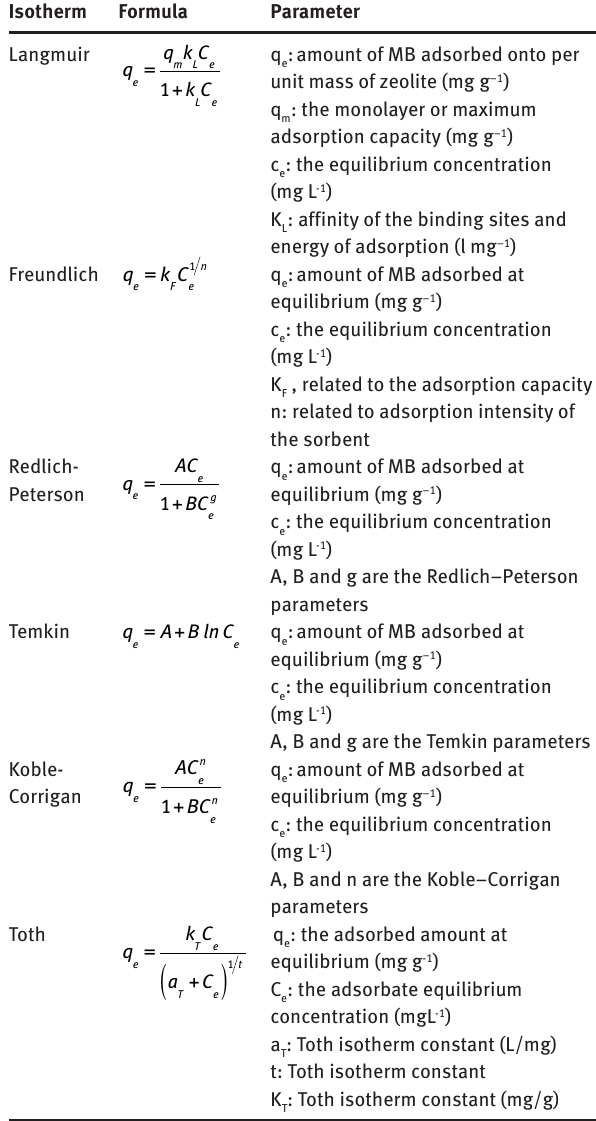
Table 1: Non-linear models of adsorption isotherms and their parameter.